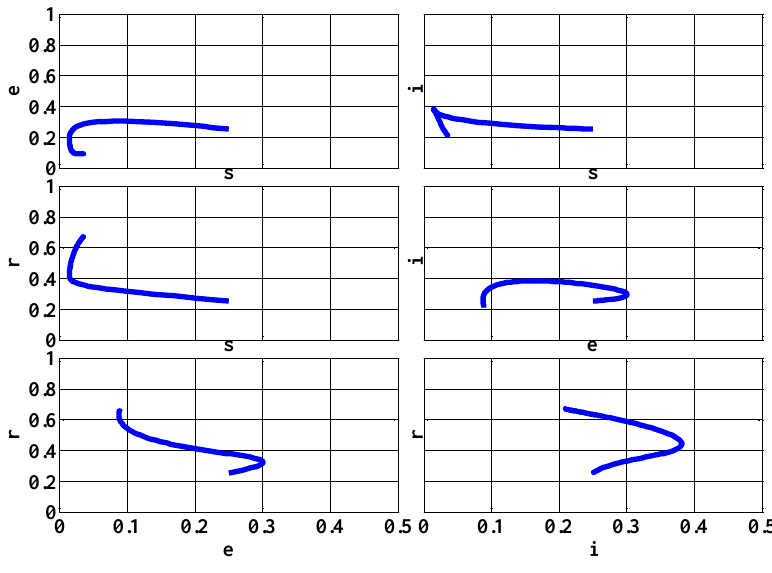
Figure 5. Phase Portraits (β = 4 (Epidemic)).